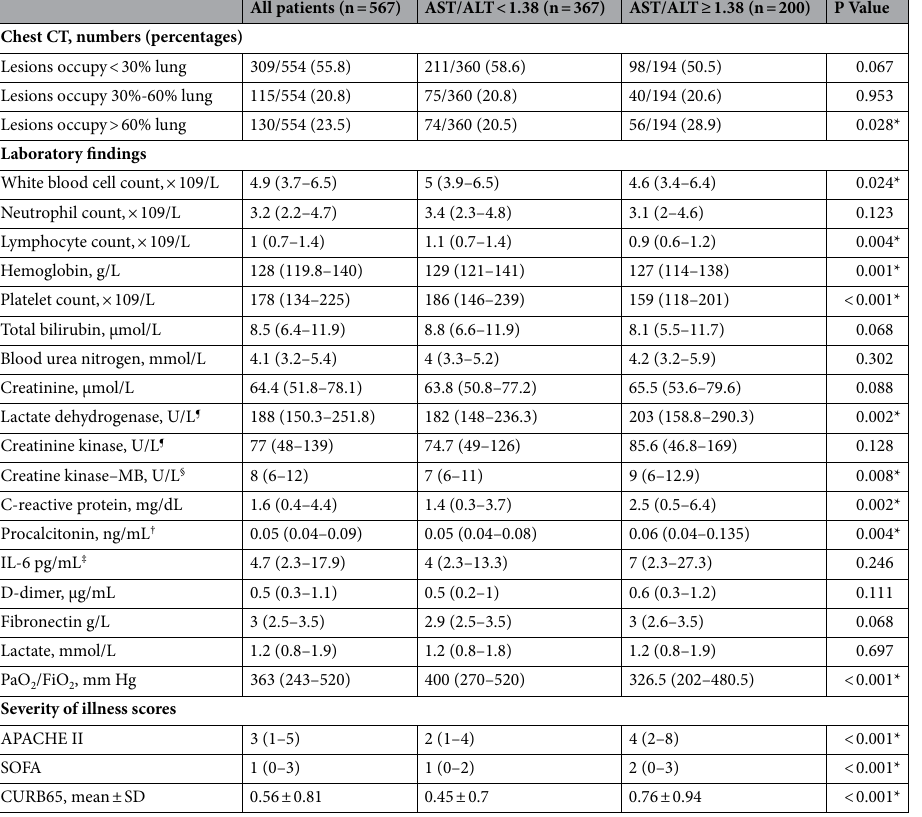
Table 2. Chest CT findings, laboratory results and severity of illness scores of COVID-19 patients on admission. Values are medians (interquartile ranges) unless stated otherwise. *A two-tailed P value less than 0.05 was considered statistically significant. Missing data for over 5% of patients are indicated: ¶ Data on LDH and creatine kinase were missing for 47 patients (8.3%), including 33 patients with AST/ALT < 1.38 (9%) and 14 patients with AST/ALT ≥ 1.38 (7%). § Data on creatine kinase-MB were missing for 42 patients (7.4%), including 31 patients with AST/ALT < 1.38 (8.4%) and 11 patients with AST/ALT ≥ 1.38 (5.5%). † Data on procalcitonin were missing for 45 patients (7.9%), including 30 patients with AST/ALT < 1.38 (8.2%) and 15 patients with AST/ALT ≥ 1.38 (7.5%). ‡ Data on creatine IL-6 were missing for 413 patients (72.8%), including 268 patients with AST/ALT < 1.38 (73%) and 145 patients with AST/ALT ≥ 1.38